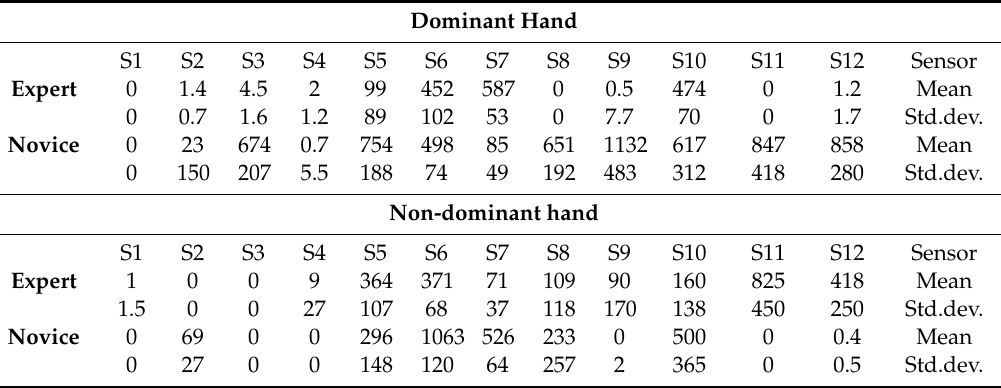
Table 1. Means and standard deviations of the expert’s and the novice’s individual grip force data (in millivolts (mV)) collected from each sensor during task execution in successive sessions with the dominant and non-dominant